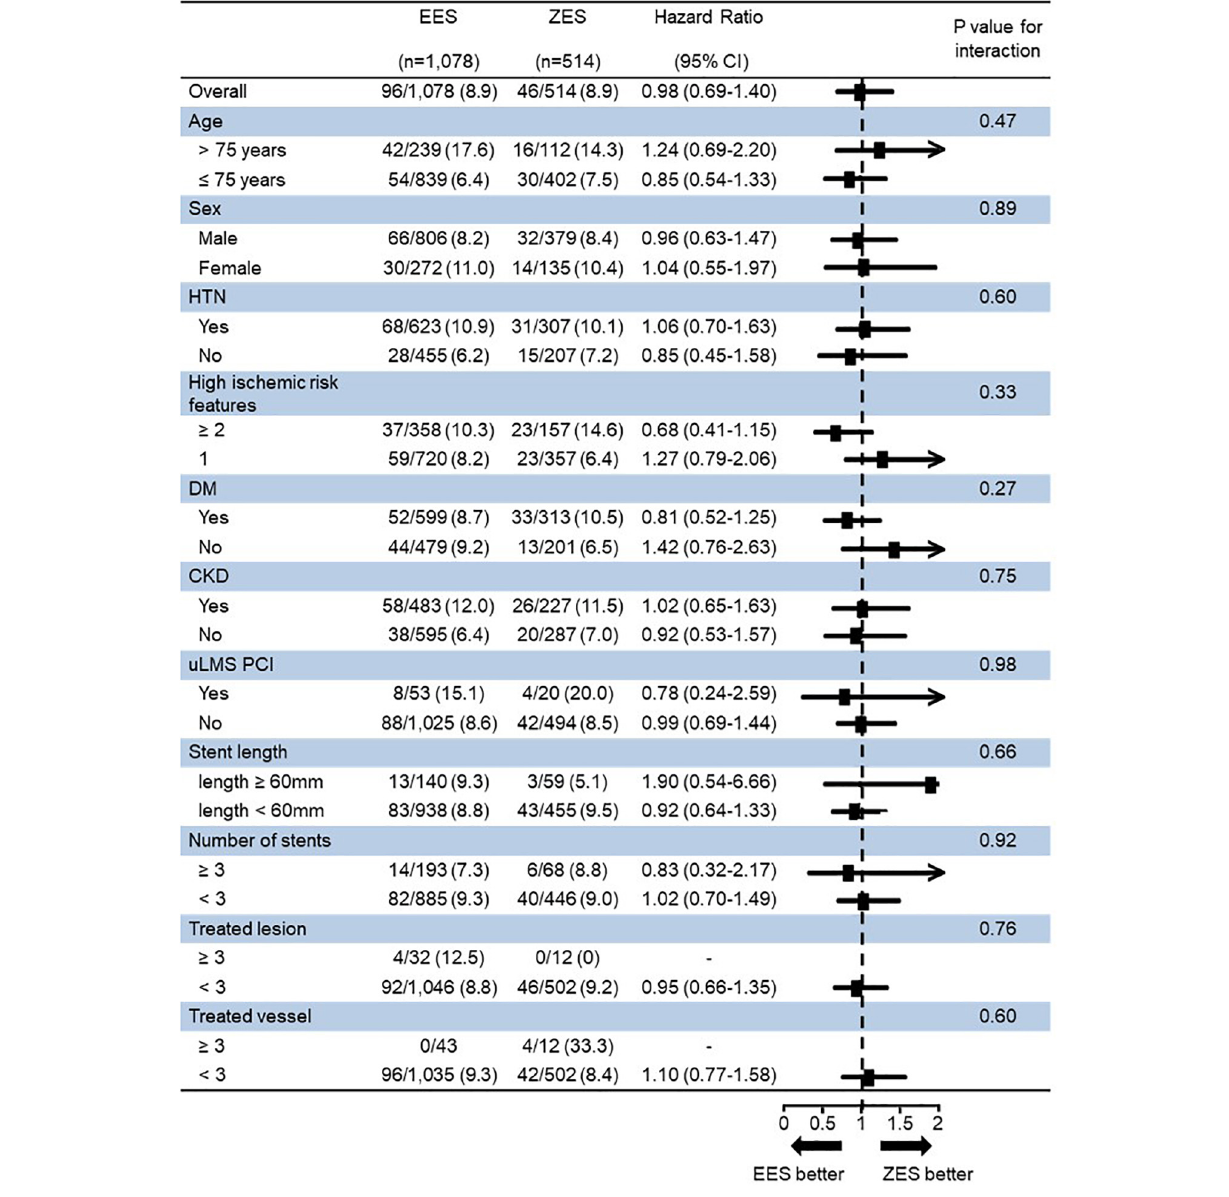
FIGURE 5 | Subgroup analysis for 3-year target lesion failure (TLF). TLF, target lesion failure; EES, everolimus-eluting stent; ZES, zotarolimus-eluting stent; HTN, hypertension; DM, diabetes mellitus; CKD, chronic kidney disease; uLMS PCI, unprotected left main stem percutaneous coronary